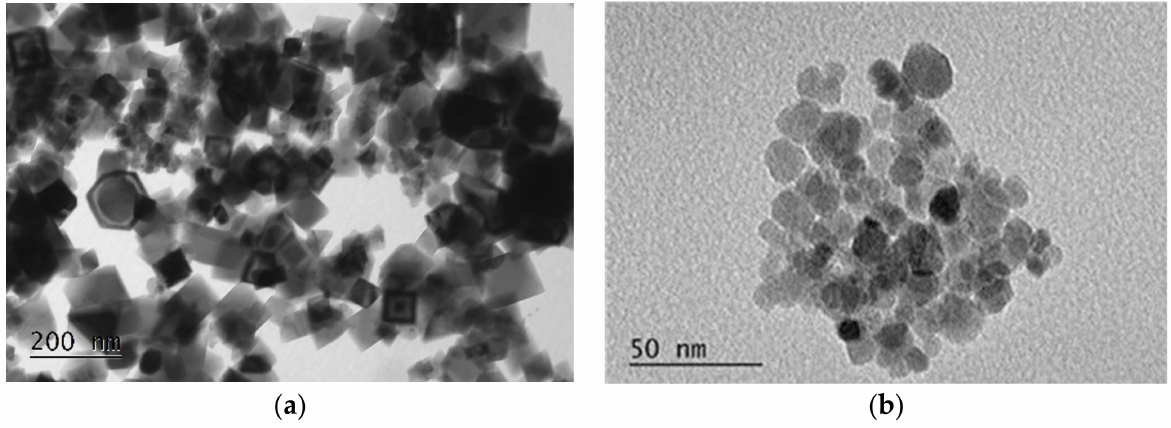
Figure 3. TEM images of ( a ) M(II) and ( b ) M(III) nanoparticles.